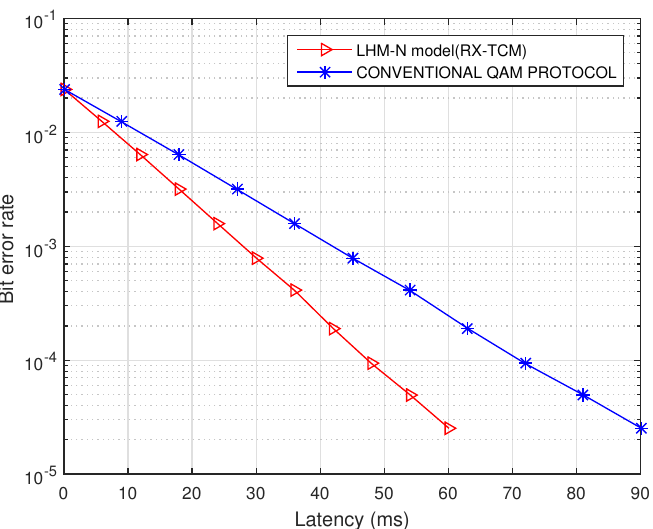
Figure 8. Comparative analysis of latency (delay) for LHM-N and the conventional QAM protocol.